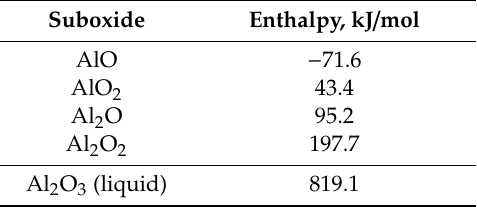
Table 1. The enthalpy of reaction in Equation (11) and liquid alumina formation